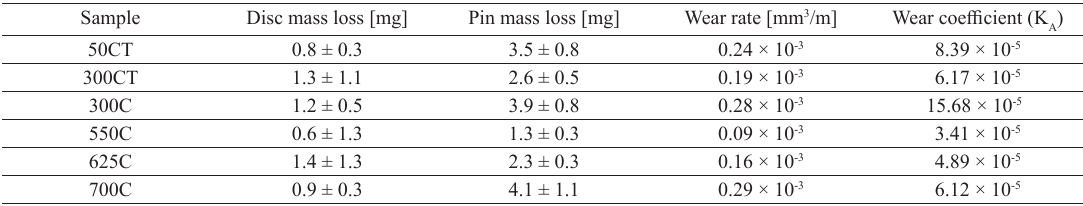
Table 2. Mass losses and wear coefficient of specimens.